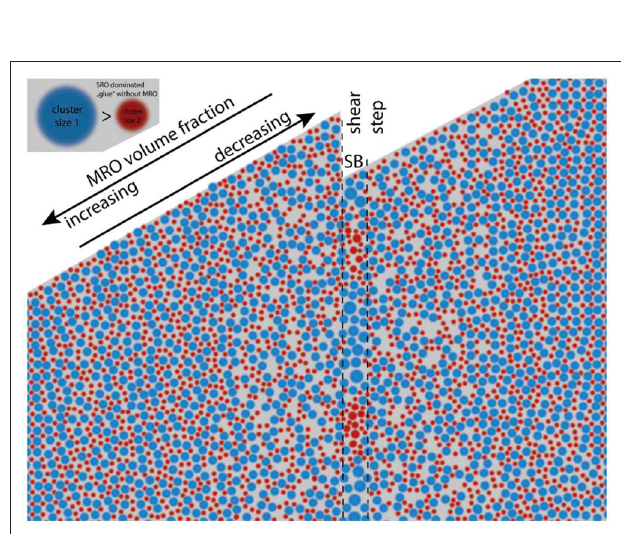
FIGURE 3 | Graphical illustration of the medium-range order (MRO) distribution around a shear band in a metallic glass as carriers for deformation accommodating the external